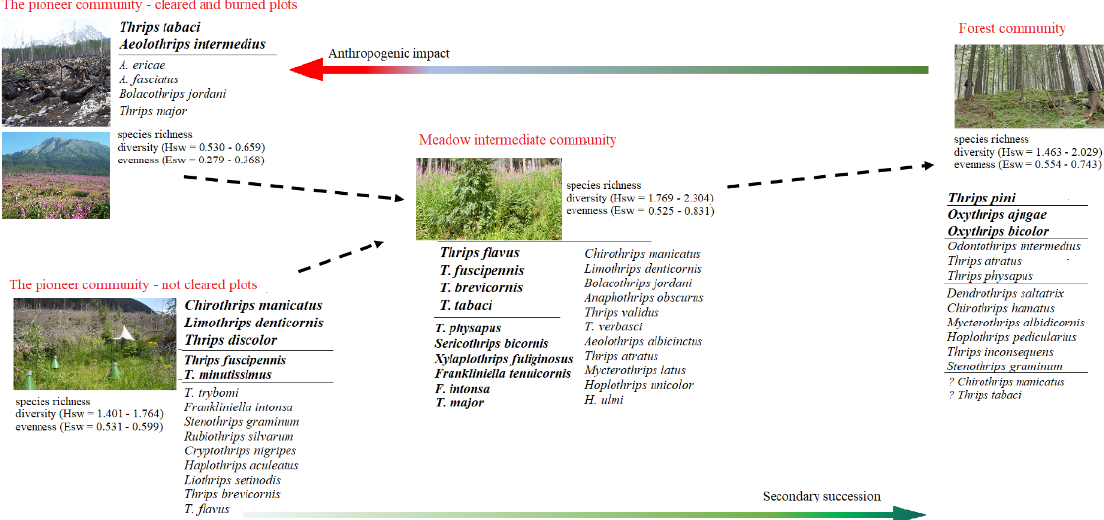
Figure 9. The changes in thrips assemblages in the context of secondary succession and anthropogenic impact in Central European spruce forests after a windthrow calamity.